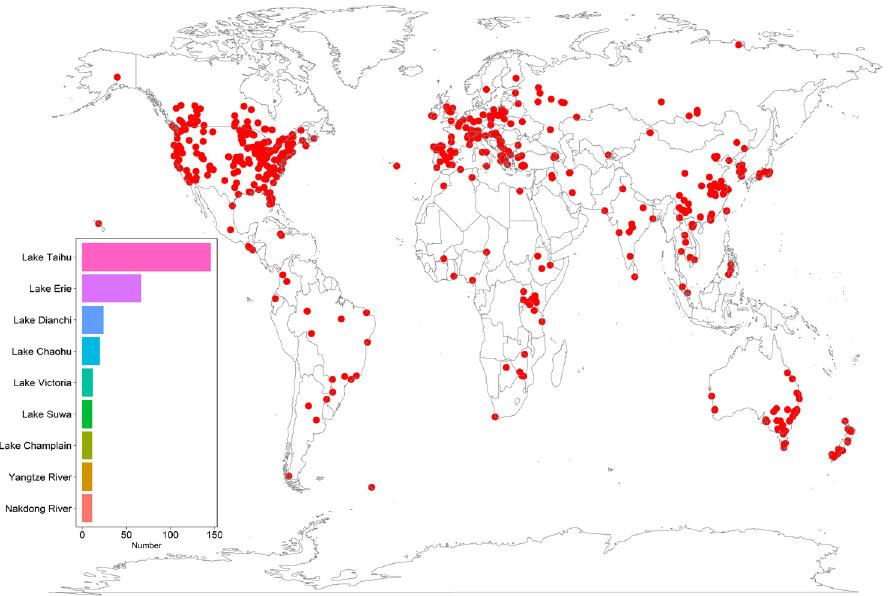
Figure 6. The distribution and occurrence frequency of lakes, reservoirs, and rivers names in abstracts of retrieved publications.